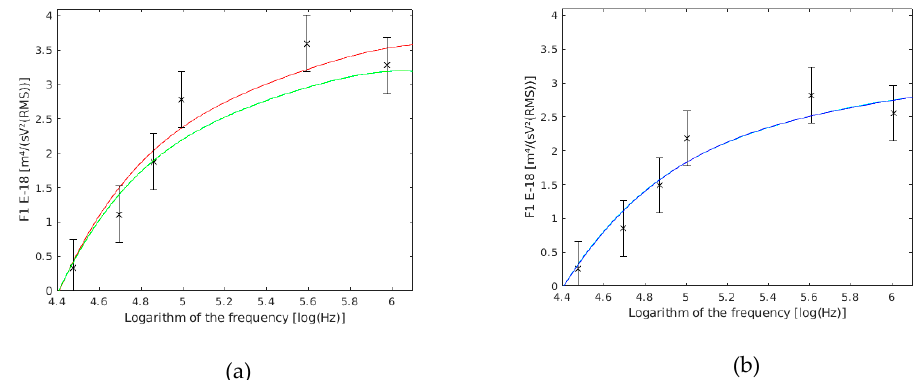
Figure 11. ( a ) 𝐹 (cid:2869) variation with the cell cytoplasm conductivity ( σ i ). 𝐹 (cid:2869) with 6 S/m inner cell conductivity are shown in red, those with 0.06 S/m cell wall conductivity are shown in green, and the results of this work are the six frequency points with their confidence intervals drawn. ( b ) 𝐹 (cid:2869) variation with the cell cytoplasm relative permittivity ( ε i ) 𝐹 (cid:2869) . with 80 inner cell permittivity are shown in cyan, those with 40 inner cell permittivity are shown in blue, and the results of this work are the six frequency points with their confidence intervals drawn. It seems to be only one line because both lines are overlapped.